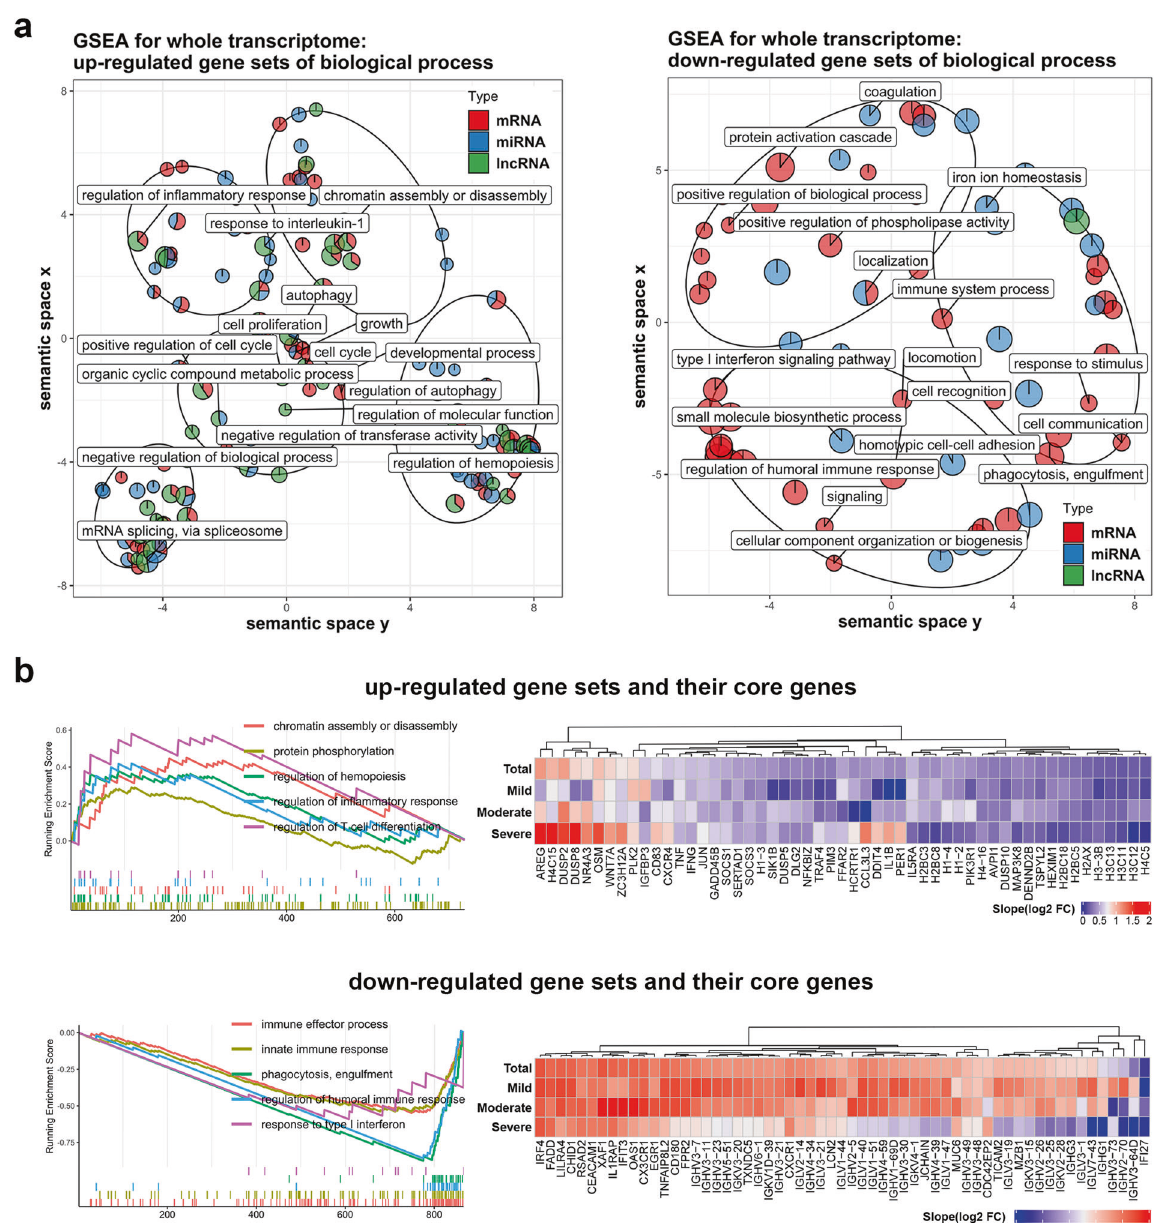
Fig. 3 Gene set enrichment analysis (GSEA) showing an immune system remolding at the whole transcriptome level. a The bubble-pie graphs displaying upregulated and downregulated gene ontology (GO) gene sets enriched by the differentially expressed mRNAs, miRNAs, and lncRNAs. The color refers to the indicated type of transcripts enriched for a gene set. The bubble size maps the sum enrichment scores of all RNA types in a gene set. The X and Y values of a gene set are calculated by REVIGO ’ s GO semantic space algorithm. 69 The ellipses refer to clusters formed by gene sets with a high semantic similarity. b GSEA plot showing the distribution of the upregulated or downregulated gene sets and the enrichment scores based on DEGs for all samples. The heat map shows the core genes in these gene sets of different clinical stages for all samples, mild, moderate and severe groups, respectively. The blue-red gradient square maps the slope of the linear regression equation of Log2 fold change of